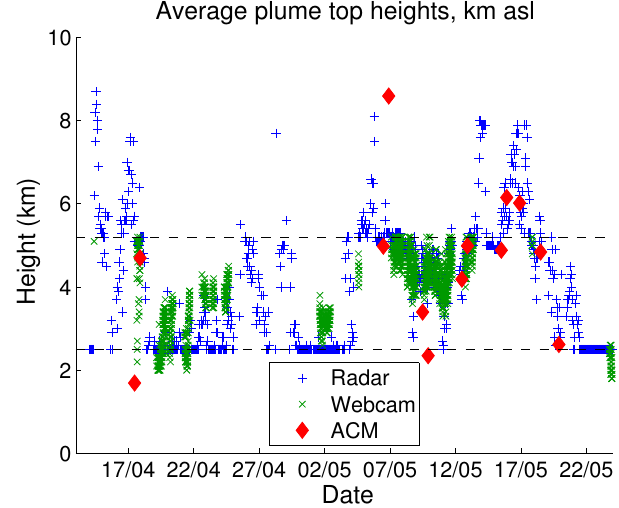
Figure 13. Ground-based plume top height data for the Eyjafjal- lajökull plume from the Keflavík weather radar and a web camera at Hvolsvöllur (Arason et al., 2011), combined with the AATSR height estimates near the volcano. The radar data is limited from below by 2.5km and the web camera data is limited from above to 5.2km (dashed black lines). The ACM data is an average over all ash-flagged single-pixel heights within 50km from the volcano (both day- and nighttime